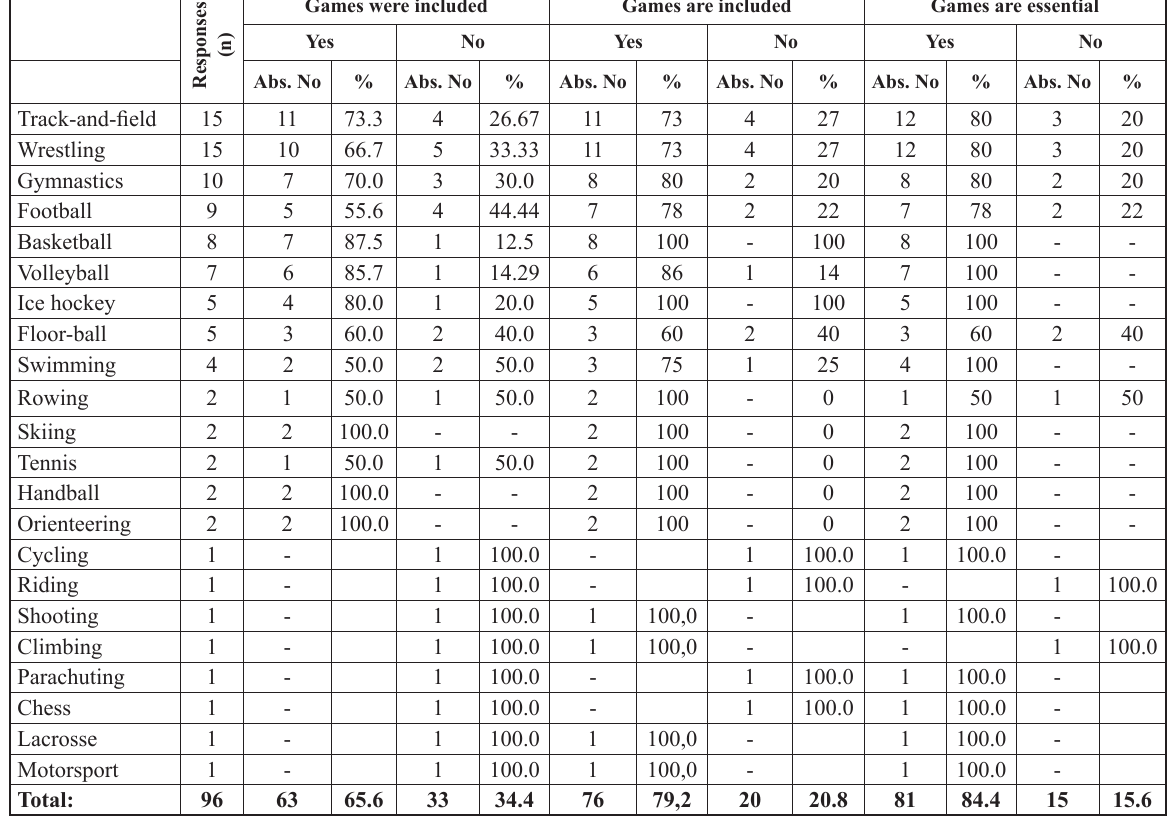
Table 1. Responses to questions 1–3 (The questionnaire survey of